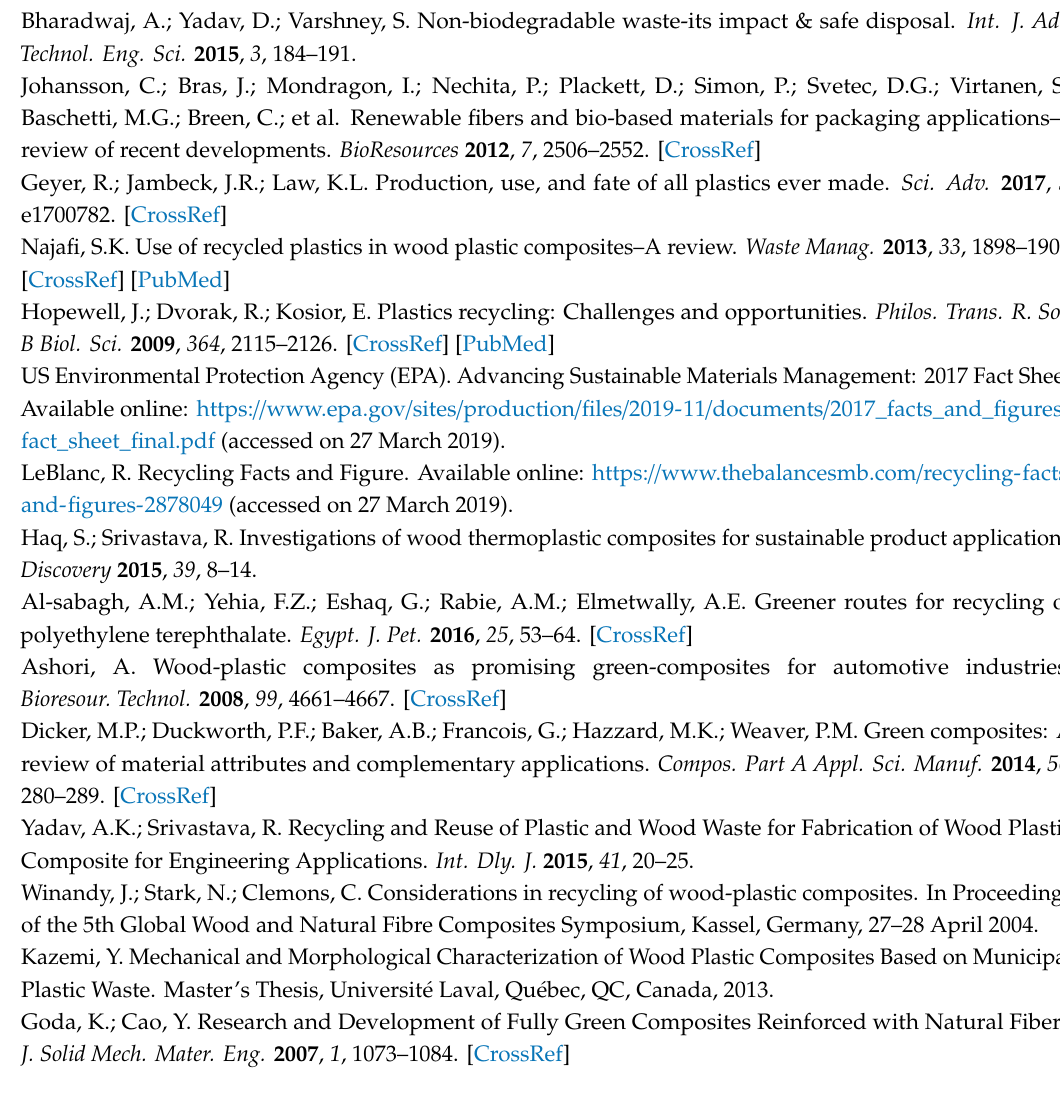
Figure S1: Model adequacy checking for rPET WPC tensile modulus; Figure S2: Model adequacy checking for rPET WPC tensile strength; Figure S3: Model adequacy checking for rPET WPC